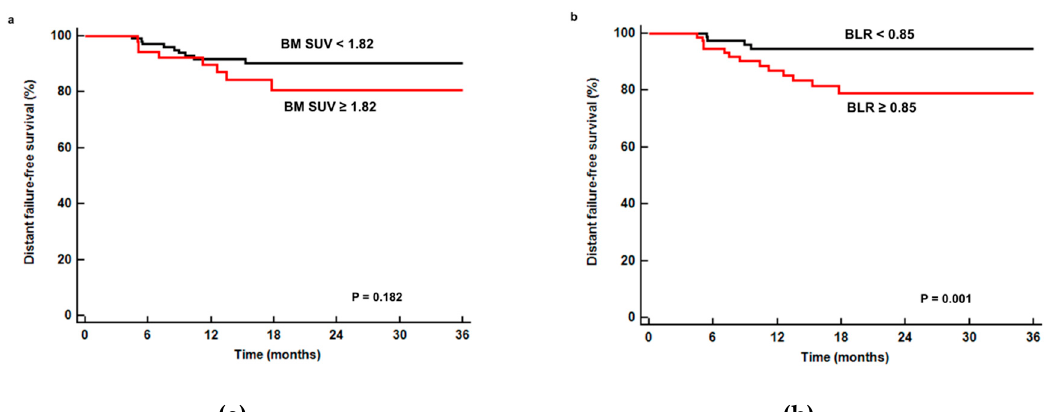
Figure 4. Cumulative distant failure-free survival curves according to BM SUV ( a ) and BLR ( b ). Patients with low BLR (<0.85) showed significantly better distant failure-free survival ( p = 0.001) than those with high BLR ( ≥ 0.85), while no significant difference of survival was shown between patients with low (<1.82) and high ( ≥ 1.82) BM SUV ( p = 0.182).